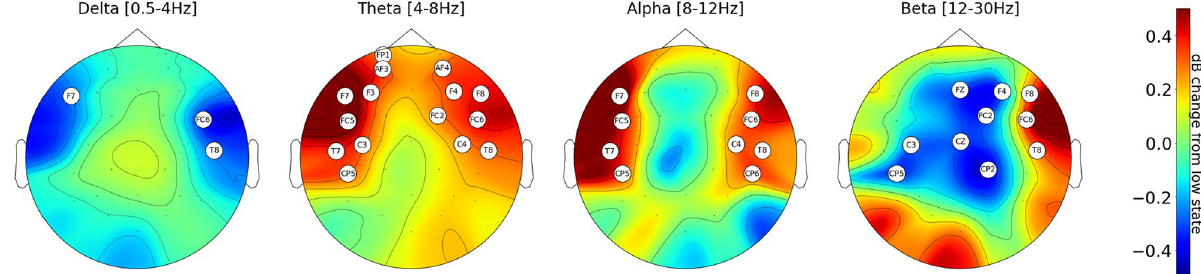
Figure 2. Mean scalp topography plot on the condition of high cognitive load for all the users with baseline subtraction. The baseline for all the channels was calculated with the data from the low cognitive state. Red areas represent increased oscillation activity in the condition of high cognitive workload while blue areas represent inhibition of the spectral activity.